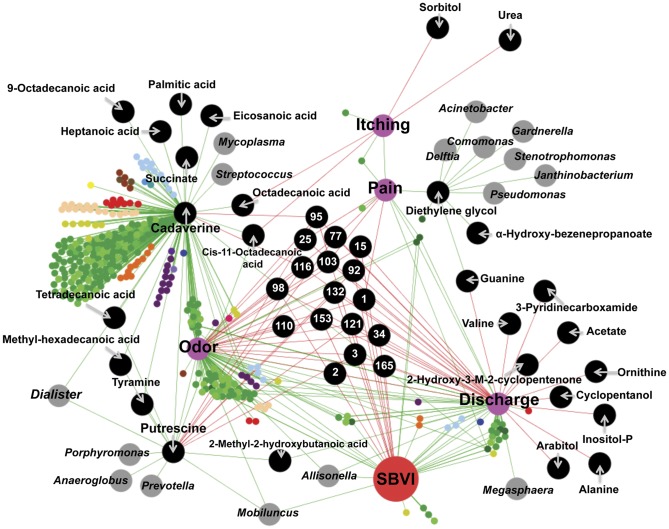
SBVI Sub-Network View of Linear Relationships among Variables.Pearson’s (between parametric data) and Spearman's (between non-parametric and either parametric or non-parametric data) correlations >0.6 (green) or <−0.4 (red) are shown as edges connecting patient metadata relating to demographics, hygiene and sexual behaviors and sexual practices, OTUs, microbial genera, metabolites and patient symptoms. Figures presented represent sub-networks of the complete network (Fig S2). Node identities are listed or described in the key for figure 7. The identities of numbered metabolites are listed in Table S2.